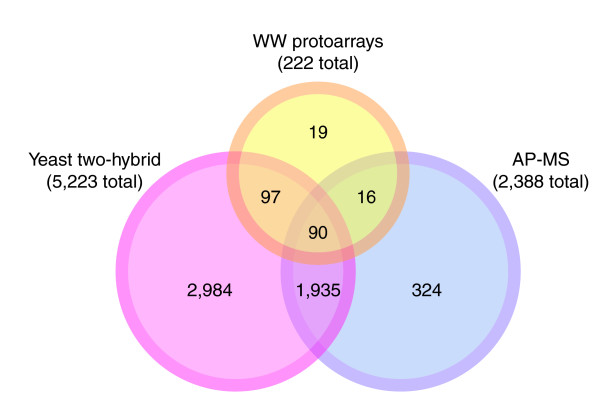
Venn diagram illustrating the representation of yeast proteins involved in protein-protein interactions found using yeast two-hybrid (Y2H) assay, protein epitope-tag affinity purification/mass spectrometry (AP-MS) and protein microarray strategies.